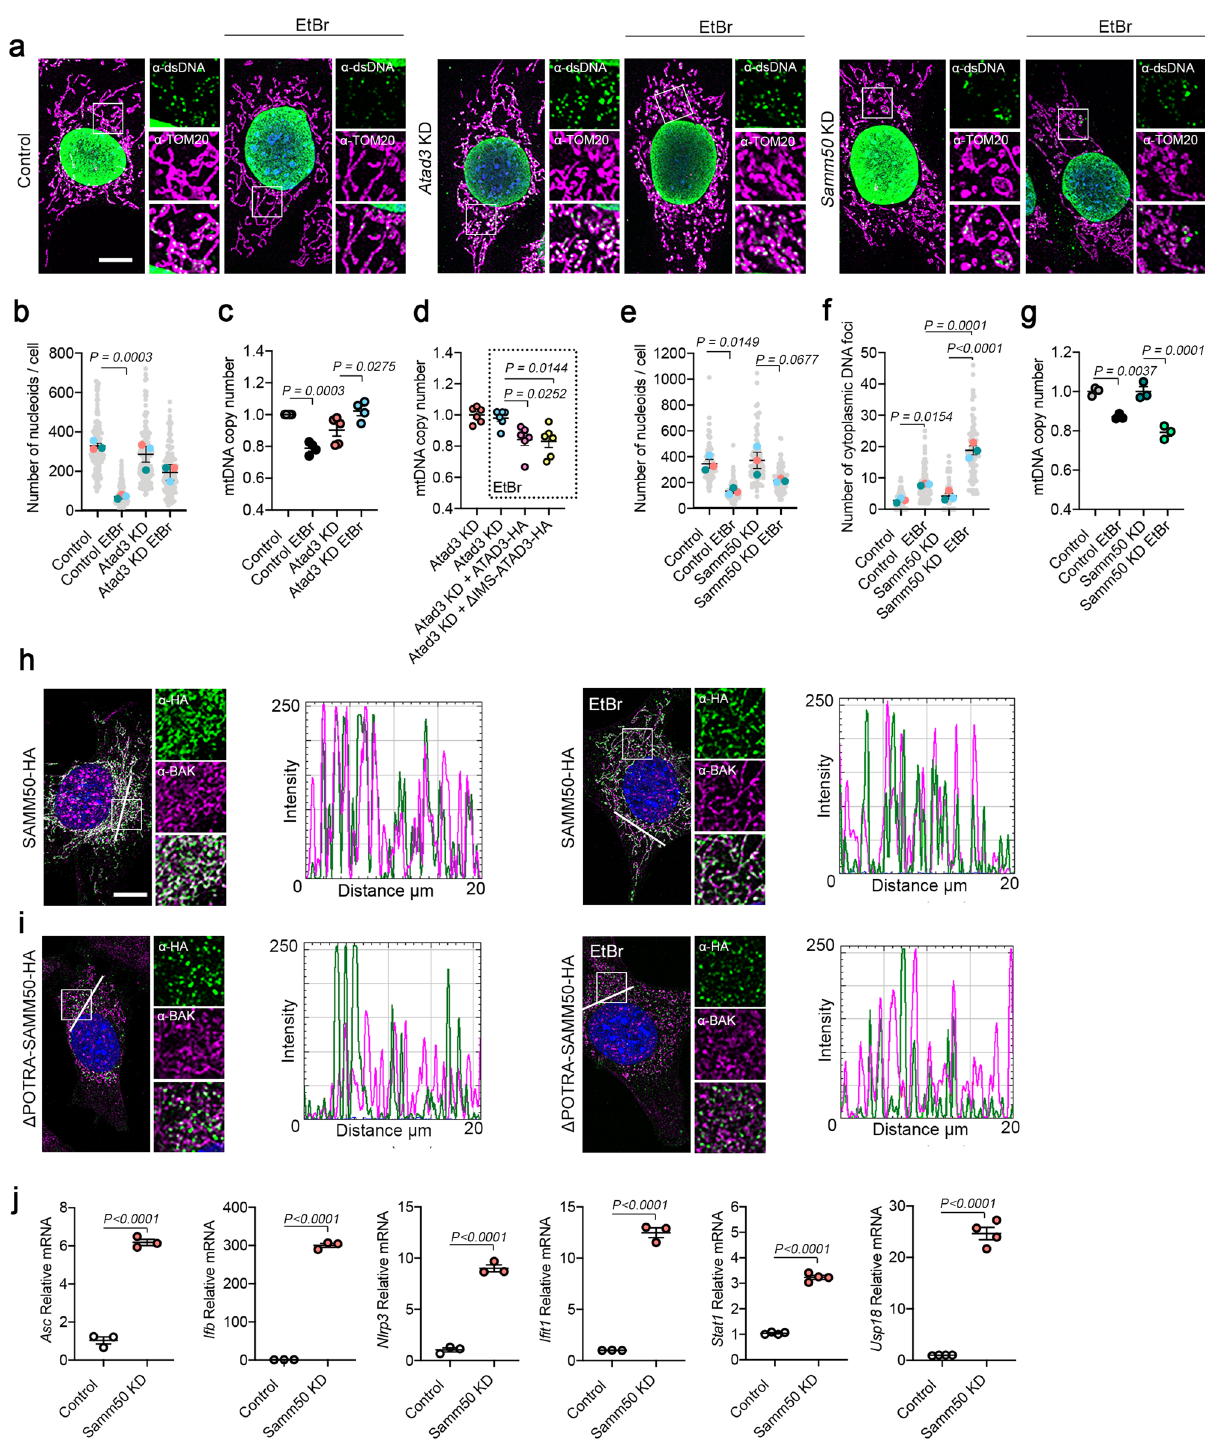
Fig.5|ATAD3andSAMM50coordinateformitochondrialnucleoidextraction. a α -TOM20 and α -dsDNA immuno fl uorescence in Atad3 and Samm50 KD MEFs in steadystateandafterEtBrtreatment. b mtDNAfociquanti fi cationin Atad3 KDcells. Only the dsDNA signal in contact with the mitochondrial marker TOM20 was considered ( n =3, >40 cells per replicate). c mtDNA copy number quanti fi cation after Atad3 KDand d aftertransduction of ATAD3-HAor Δ IMS-ATAD3-HAand EtBr treatment( n =6independentcultures). e mtDNA fociquanti fi cation after Samm50 KD in steady state and after EtBr treatment inside the mitochondrial matrix and f located in the cytosol. ( n =3, >20 cells per replicate). g mtDNA copy number